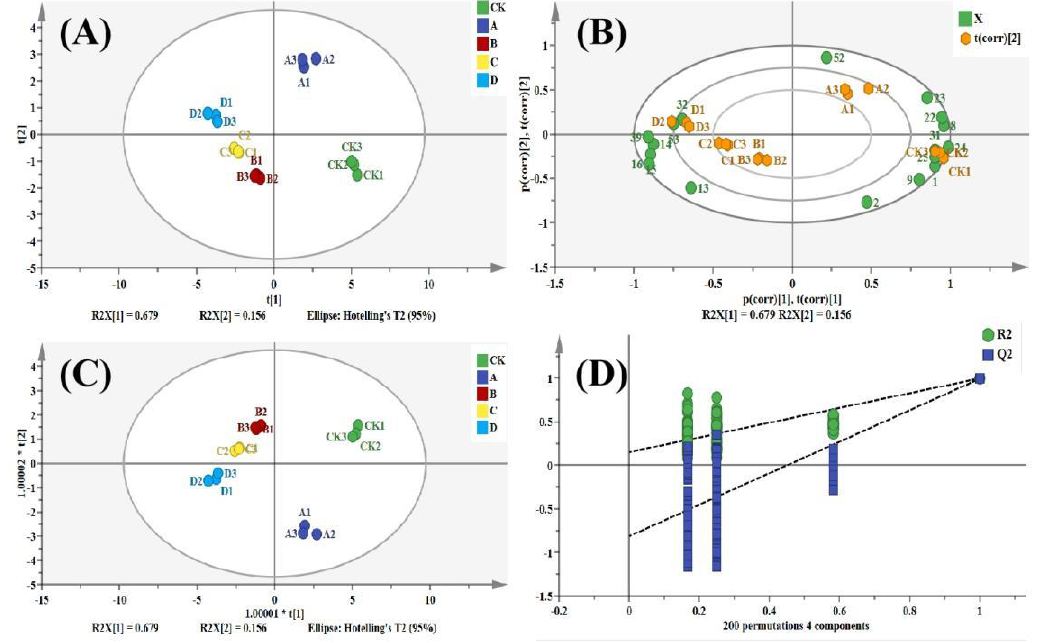
Figure 4. PCA and OPLS − DA analysis of key flavor components in pomegranate seeds at different processing temperatures. ( A ) PCA score scatter plot; ( B ) PCA biplot; ( C ) OPLS-DA score scatter plot; ( D ) OPLS-DA model validation plot.